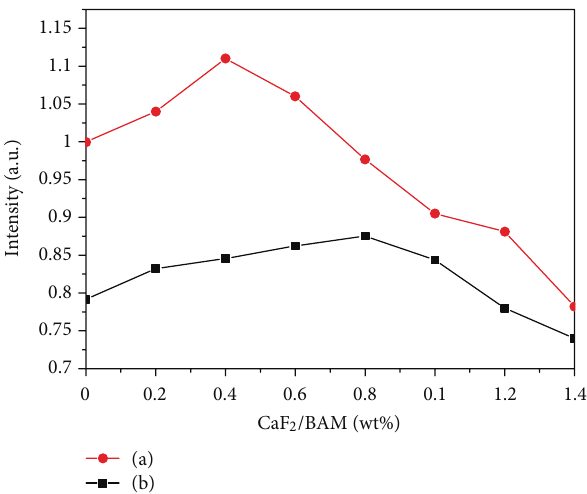
Figure 5: Photoluminescent intensities of CaF 2 -coated BAM phos- phors as a function of the weight ratio CaF 2 /BAM (a) before heat = 254 nm, 𝜆 = 450 nm). ex em treatment and (b) after 600 ∘ C heat treatment ( 𝜆 450